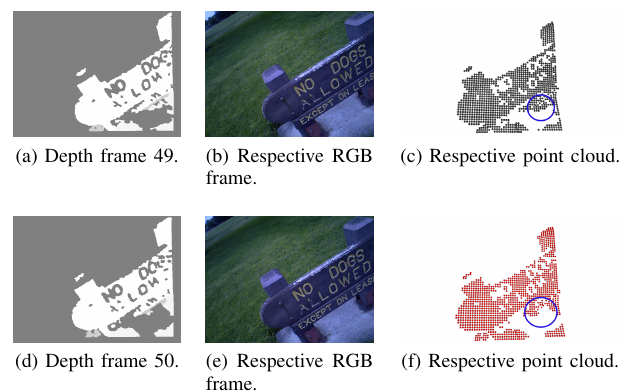
Fig. 15: A pair of depth frames (15a, 15d) and their respective RGB frames (15b, 15e) and point clouds (15c, 15f).